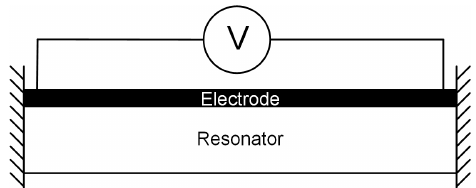
Figure 2. Schematic of electrothermal transduction on an MEMS